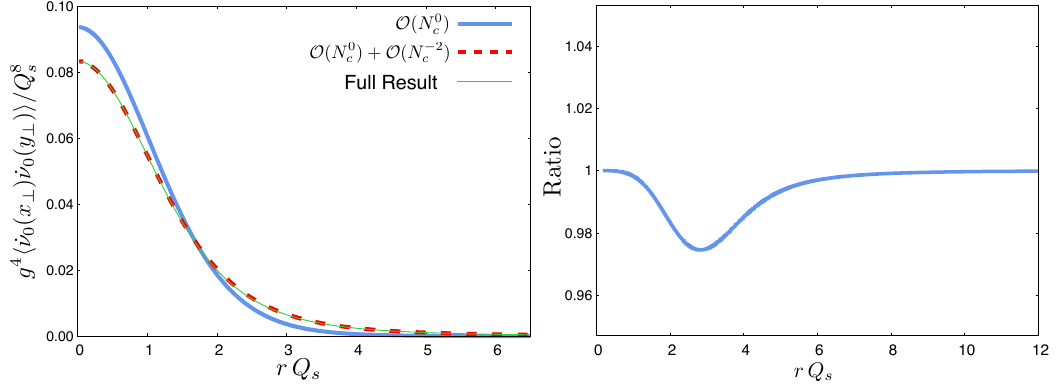
Figure 3. Left: comparison of the (cid:12)rst two orders of the N of the divergence of the Chern-Simons current against r Q s in the GBW model for Q s N c =3. Blue full curve: N 0 -order term. Red dashed curve: sum of N 0 c green curve: full result. Right: ratio between the full result and the sum of the (cid:12)rst two orders of the N c